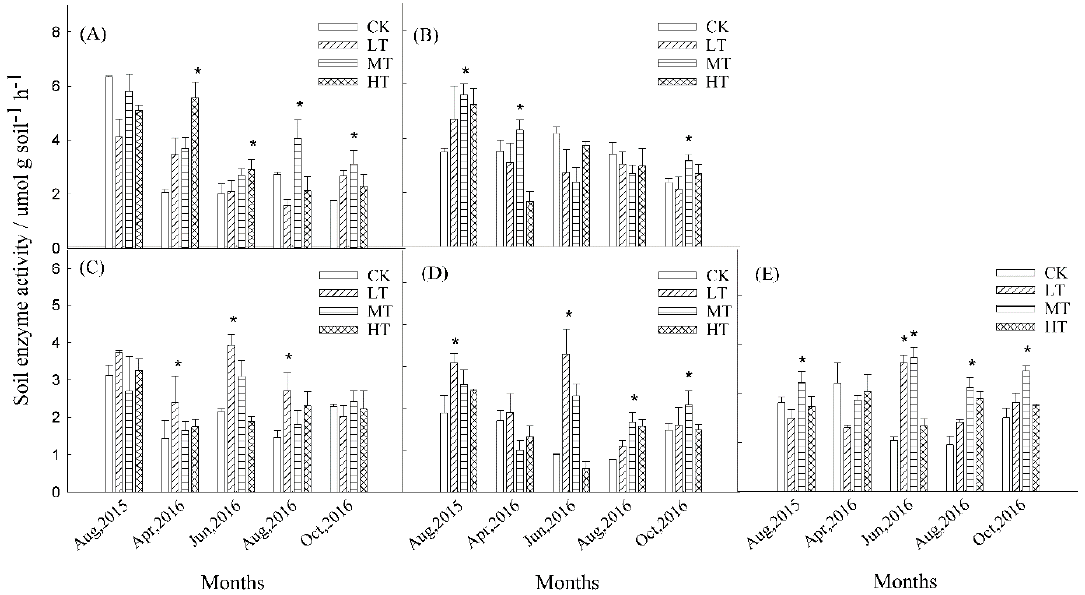
Figure 1. Variation in the activities of phenol oxidase ( A ), peroxidase ( B ), BG ( C ), NAG ( D ), and CBH ( E ) after different thinning treatments. BG: β -glucosidase; NAG: N-acetyl- β -glucosidase; CBH: cellobiohydrolase; LT: light thinning; MT: medium thinning; HT: high thinning. * indicate significant